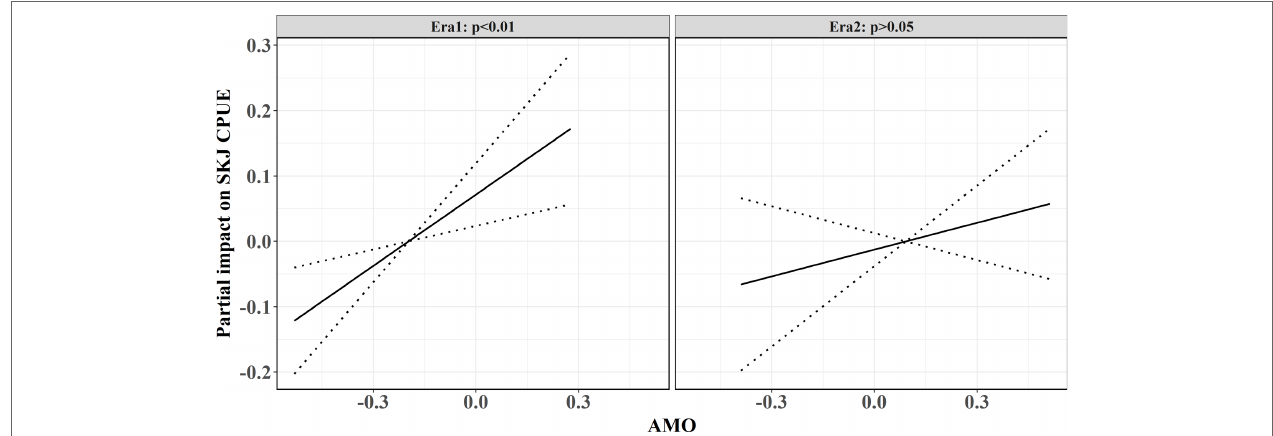
FIGURE 8 | Fitting relationships between the AMO and SKJ CPUE in various eras using the best-fitted models. The left and right panels represent the first era before 1991 and the second era posterior 1991,